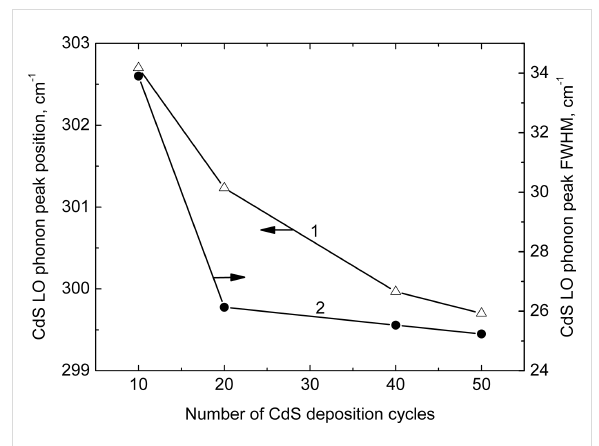
Figure 6: Dependence of the CdS LO phonon peak position (1) and FWHM (2) on the number of SILAR